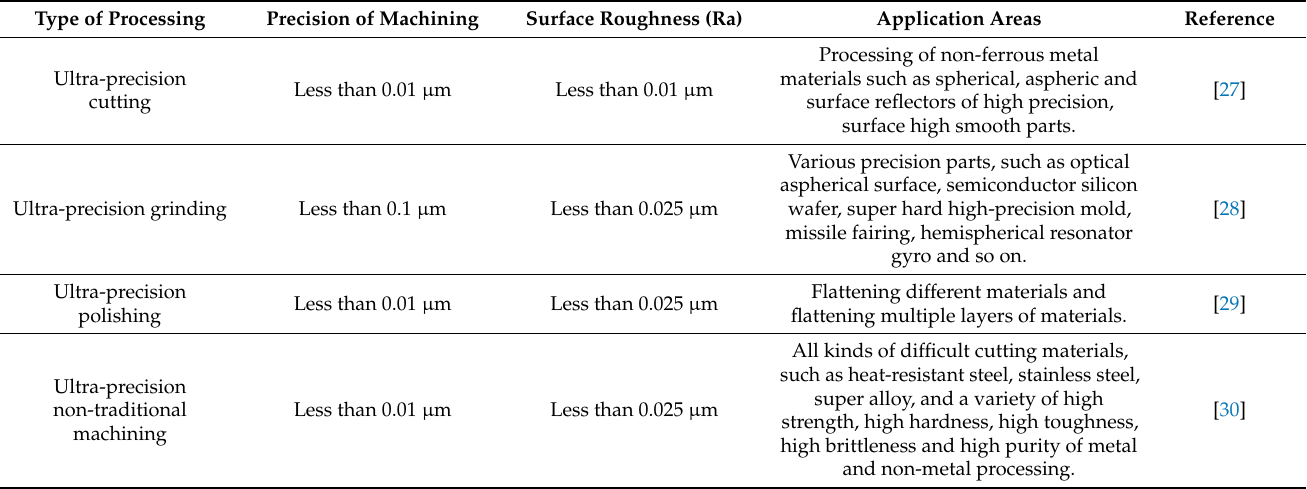
Table 1. Machining accuracy of different processing